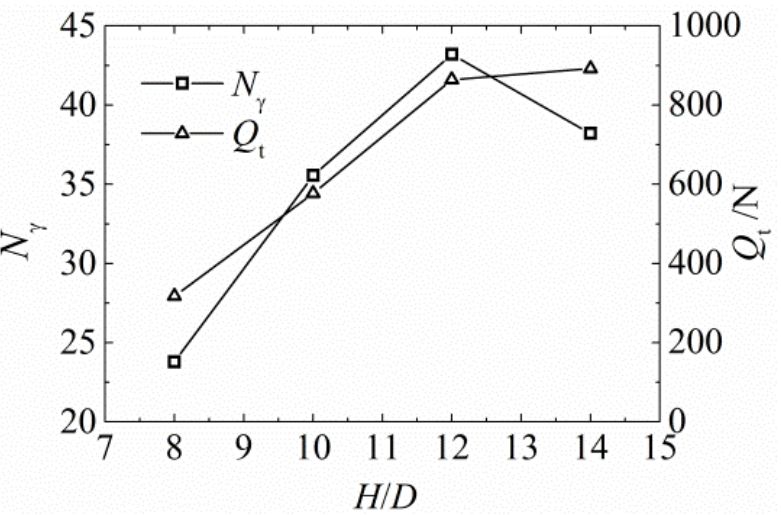
Figure 4. N γ and Q t of helical anchors with different embedment ratios in dense sand.